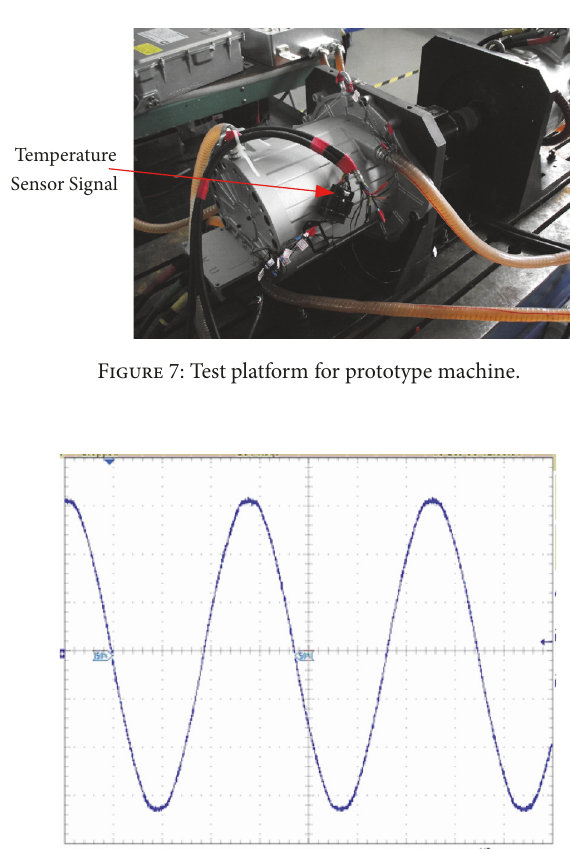
Figure 8: No-Load line back-EMF measured waveform at 4000r/min.